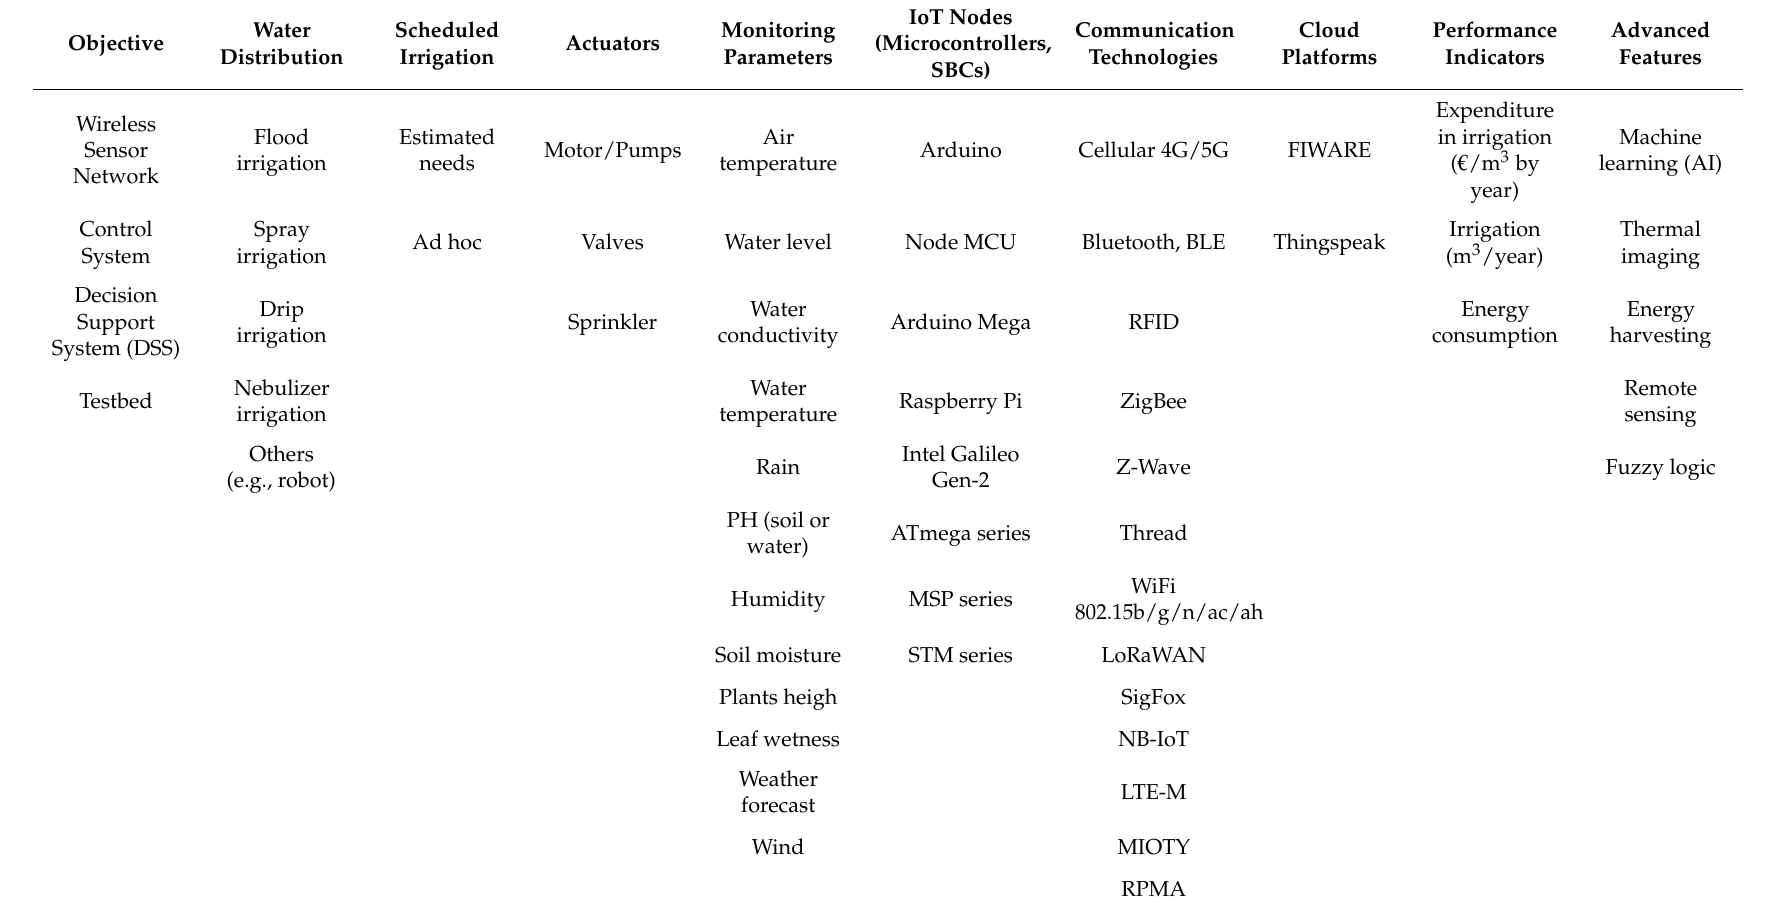
Table 1. Overview of the main aspects of smart irrigation